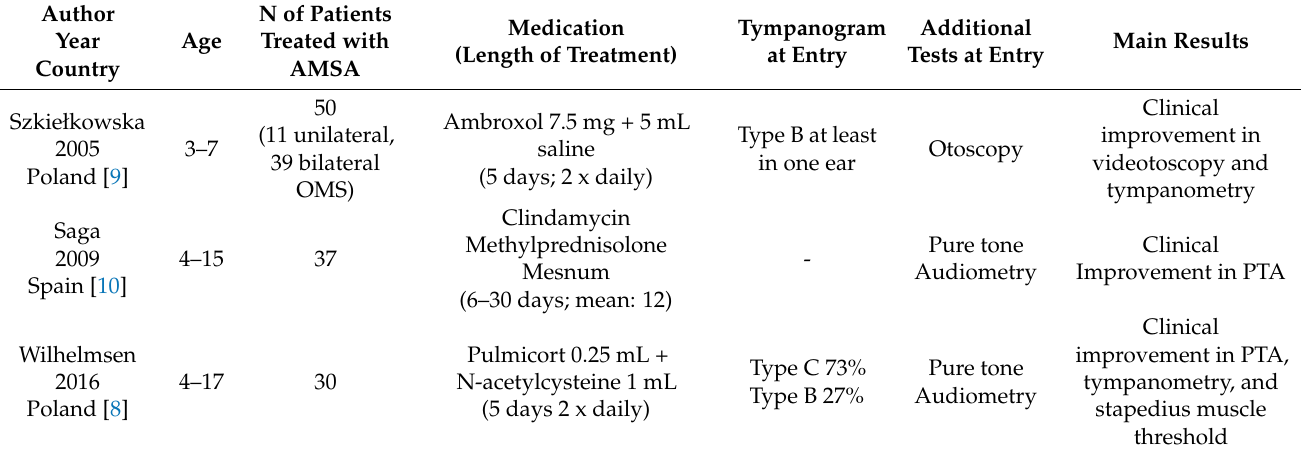
Table 4. Summary of previously published interventional studies utilizing ASMA